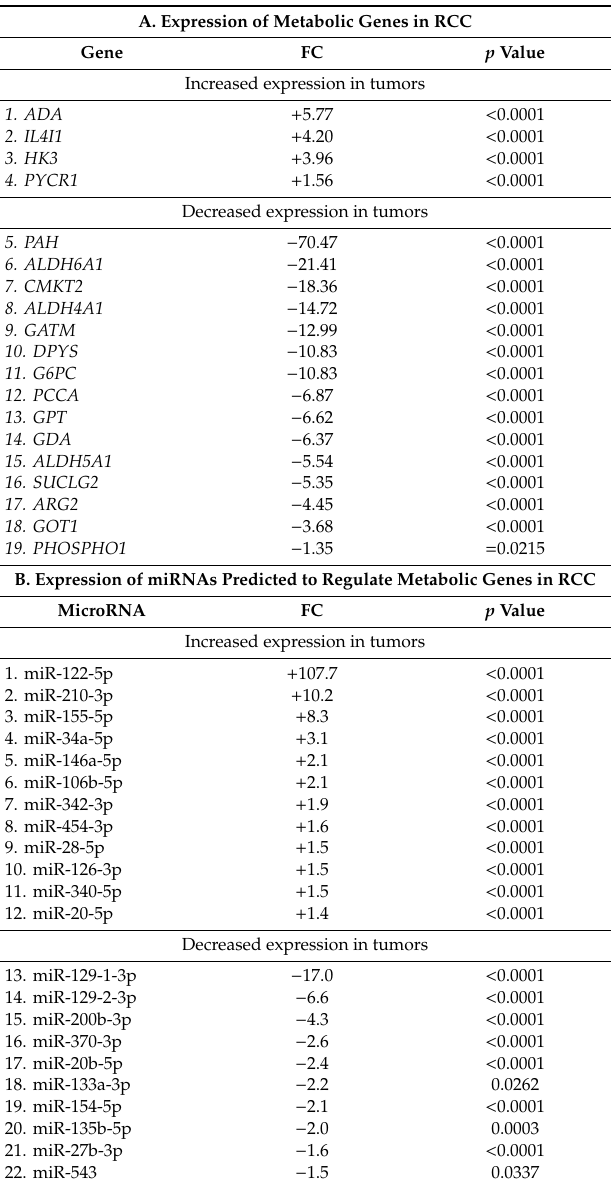
Table 1. The expressions of genes involved in the regulation of cell metabolism and their predicted regulatory miRNAs are altered in RCC tumor